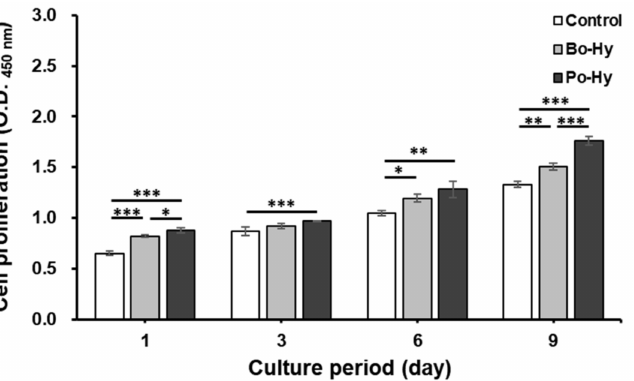
Figure 6. Cell proliferation of xenograft extracts on MC3T3-E1. Significant differences were observed when compared with the controls: * p < 0.05, ** p < 0.01, *** p < 0.001, n =